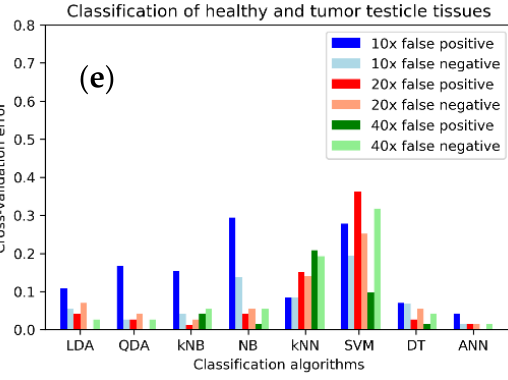
Figure 4. Cross-validation error, distinguishing the false positive and false negative rates, for each tissue type, classifier and magnification: ( a ) Brain tissue; ( b ) Ganglion tissue; ( c ) Liver tissue; ( d ) Kidney tissue; ( e ) Testicle tissue. LDA: linear discriminant analysis; QDA: quadratic discriminant analysis; NB: Naïve Bayes; kNB: kernel Naïve Bayes; kNN: k-nearest neighbors; SVM: support vector machine; DT: decision tree; ANN: artificial neural network.